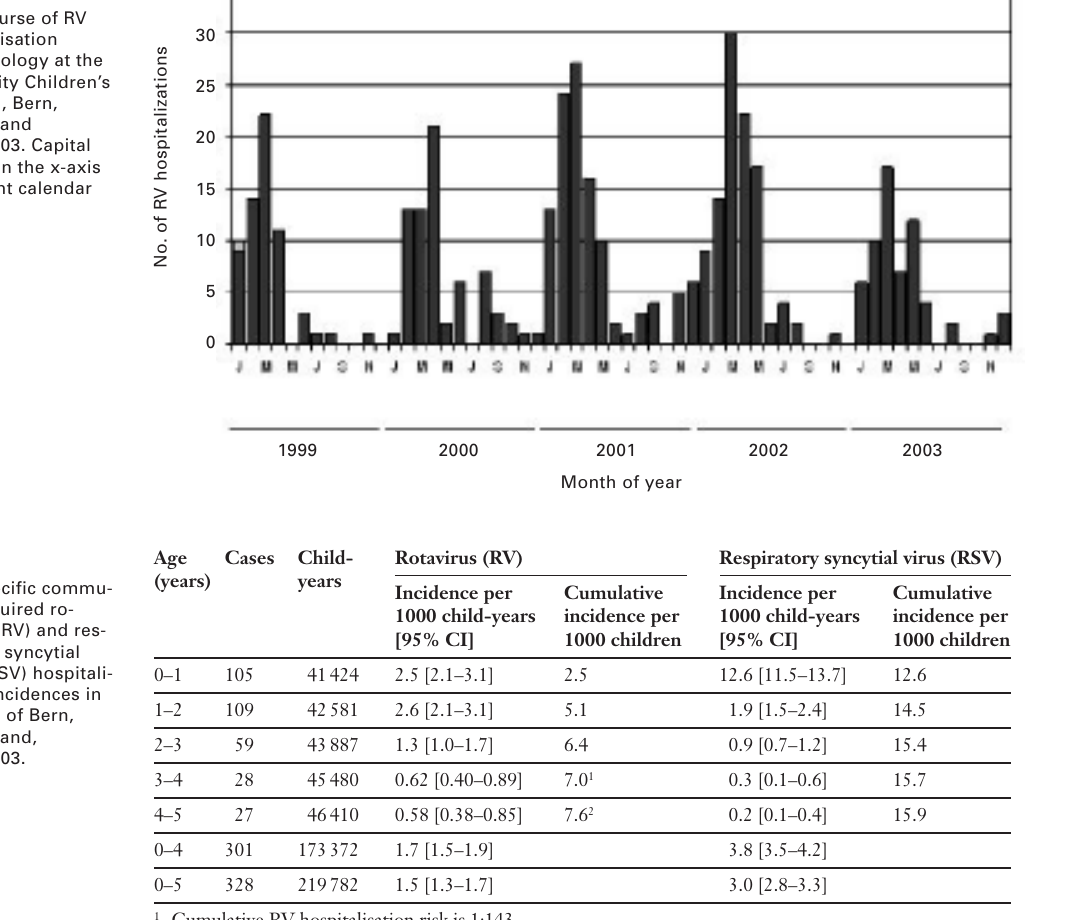
Time course of RV hospitalisation epidemiology at the University Children’s Hospital, Bern, Switzerland 1999–2003. Capital letters on the x-axis represent calendar months.